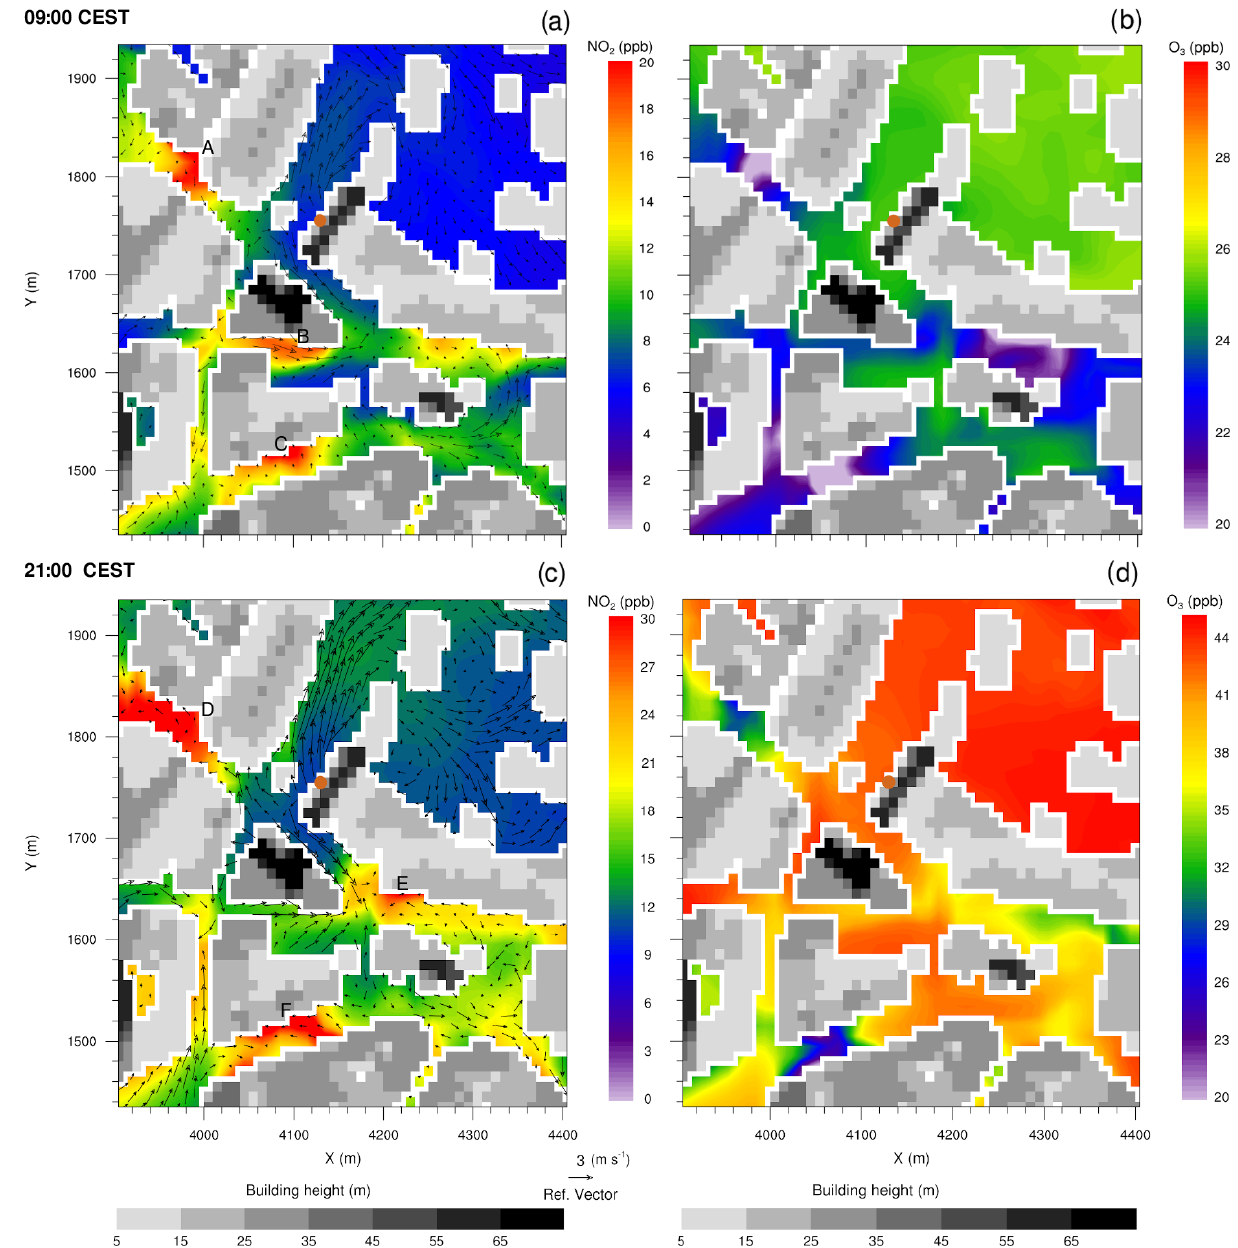
Figure 7. Near-surface NO 2 and O 3 concentrations in the street canyons near Hardenbergplatz, simulated with the CBM4 mechanism at 09:00 and 21:00CEST on 17 July 2017. The wind vectors in (a) and (c) show horizontal wind speed 5m above the surface. The filled brown dot in (a) indicates the location of Hardenbergplatz air quality station. Grey shading indicates building height.